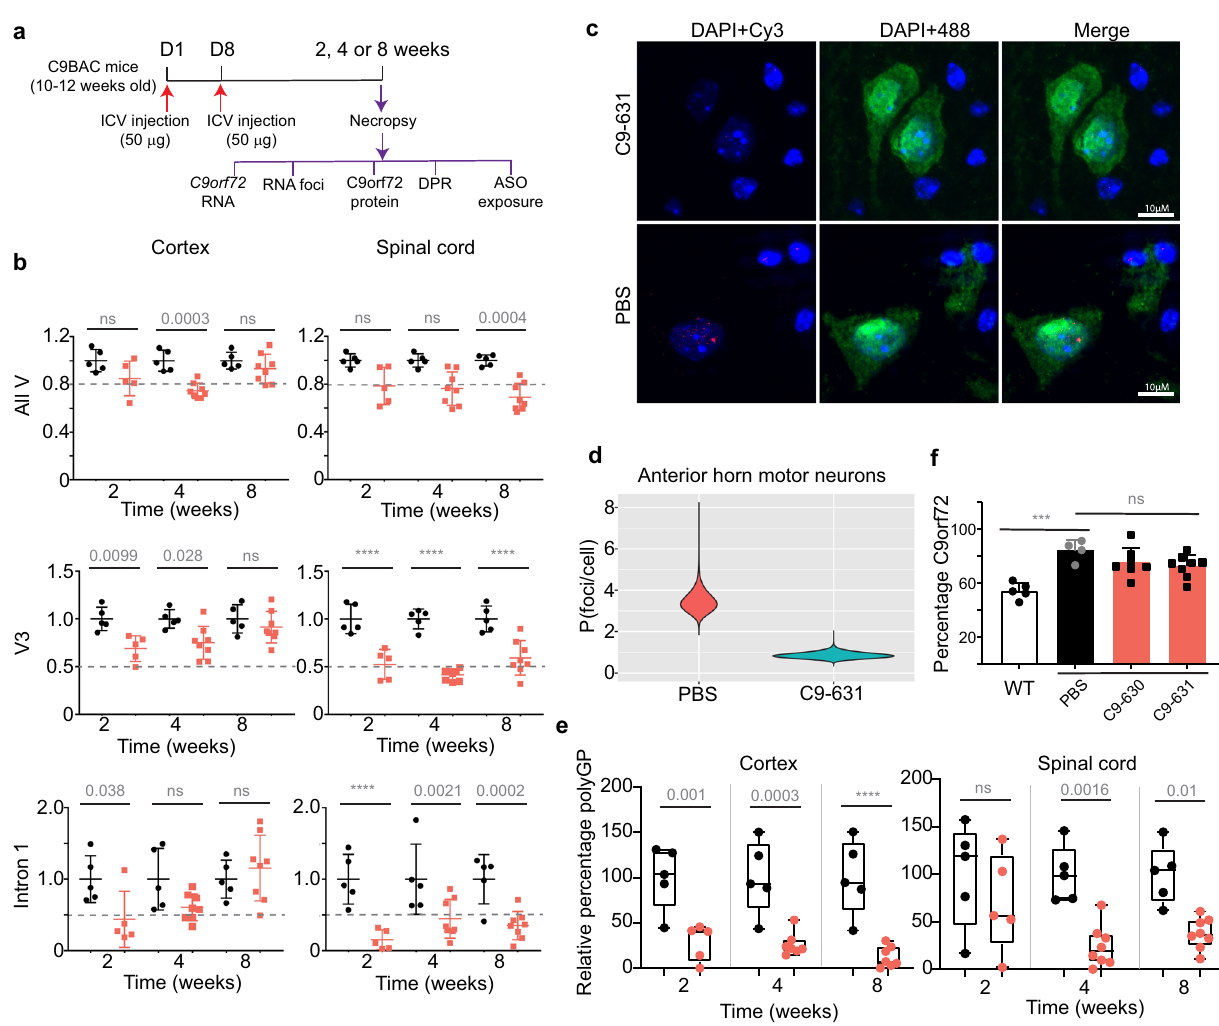
Fig. 5 Stereopure oligonucleotides show durable activity in C9BAC mice. a Schematic representation of dosing regimen for 8-week study, with mice administered oligonucleotide on days (D) 1 and 8 and evaluated at 2, 4, or 8 weeks. b Relative transcript levels of all variants (top), V3 (middle), or intron 1- containing transcripts (bottom) in cortex (left) or spinal cord (right) at 2-, 4-, and 8-weeks post-dose are shown for C9orf72-631-treated (coral, n = 7) and PBS-treated mice (black, n = 5). C9orf72 transcripts are standardized to Hprt , individual points indicate data from one mouse, and data are presented as mean ± SD. Two-way ANOVA with Sidak ’ s multiple comparisons. Exact P values are indicated, ns non-signi fi cant. c Representative images from evaluation of four mice per treatment group, showing spinal cords of mice treated with C9orf72-631 (top) or PBS (bottom) and stained for RNA foci (Cy3-labeled probe, red), nuclei (DAPI, blue), and motor neurons (anti-NeuN, green). 10 μ m scale bars are shown. d Quanti fi cation of RNA foci per cell in anterior horn motor neurons in mice treated with PBS (fuschia) or C9orf72-631 (aqua) (Supplementary Fig. 8). e Relative percentage of DPR proteins detected in cortex (left) or spinal cord (right) for PBS (black, n = 5) or C9orf72-631 (coral, n = 7) at 2-, 4- and 8-weeks post-dose. Box plots show minima to maxima with horizontal lines depicting means. Two-way ANOVA with Sidak ’ s multiple comparisons. f Normalized percentage expression of C9orf72 protein in the spinal cord of wild-type ( n = 5) or C9BAC mice treated with PBS (black, n = 4), C9orf-630 (coral, n = 7) or C9orf72-631 (coral, n = 8) at 8 weeks. Data are presented as mean ± SD. Two-way ANOVA with Dunnett ’ s multiple comparisons. ns, non-signi fi cant. Source data are provided as a Source Data fi le. ASO antisense oligonucleotide, ICV intracerebroventricular, DPR dipeptide-repeat protein; PBS phosphate-buffered saline, All V all variants, WT wild type mice, P probability; polyGP, polyglycine –